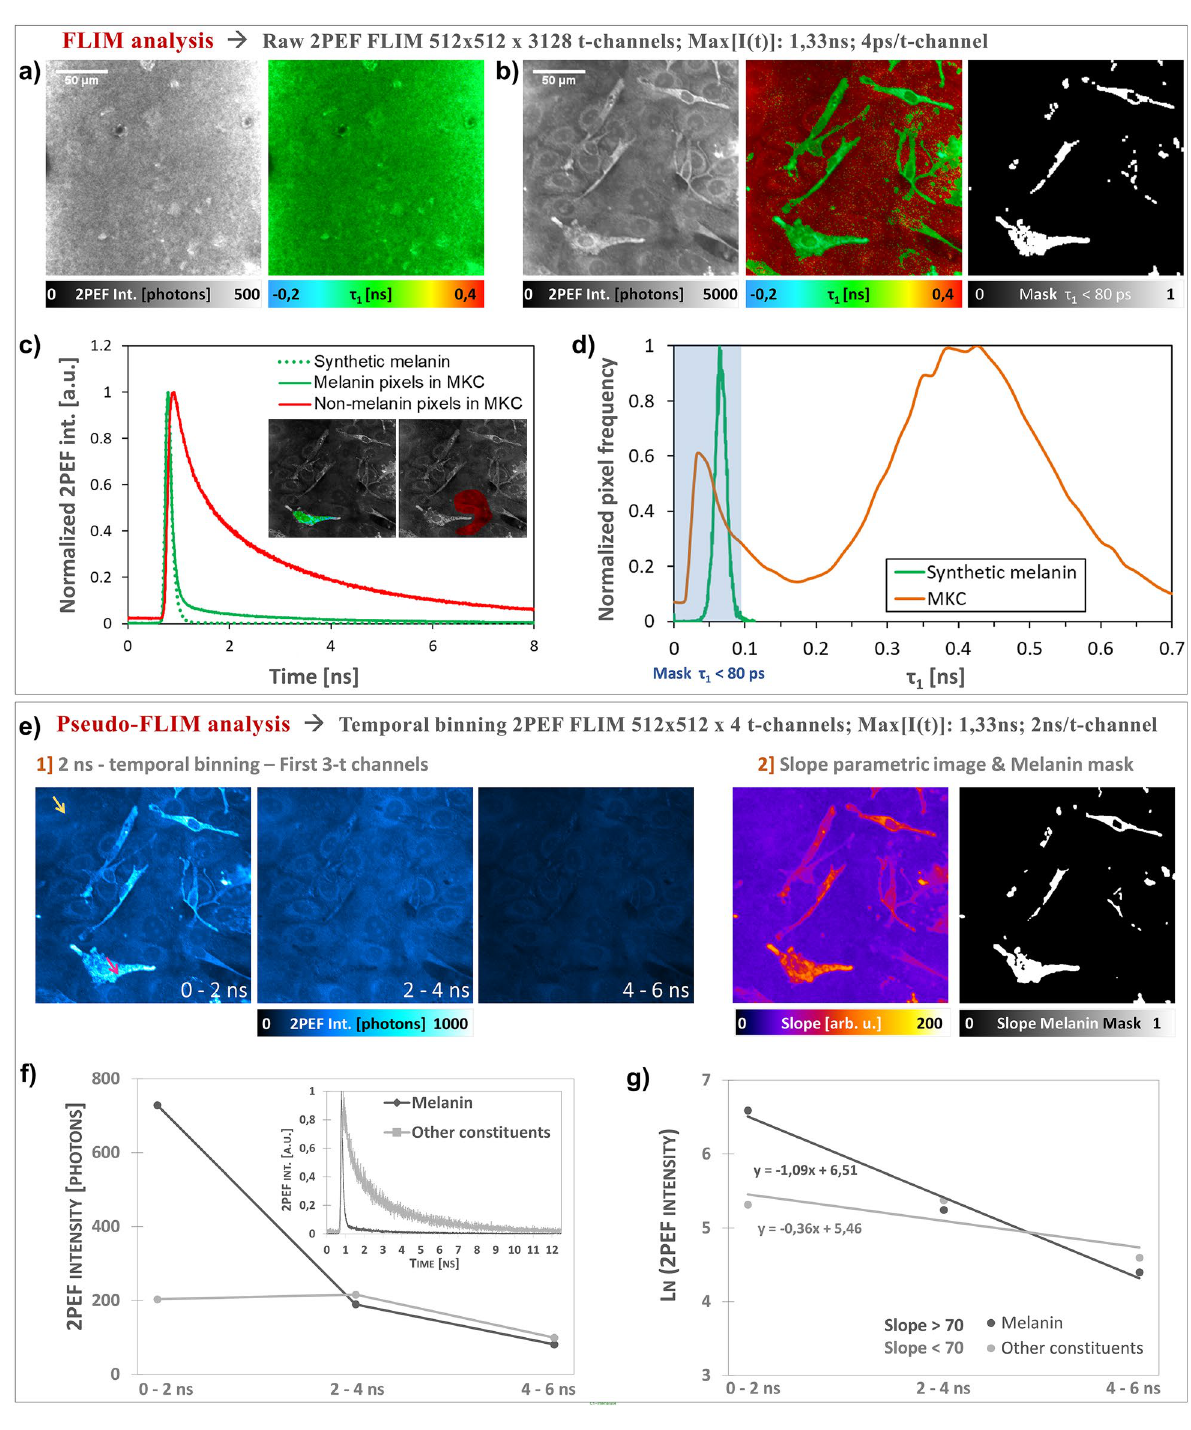
Figure 3. Comparison of FLIM bi-exponential fitting and Pseudo-FLIM methods for melanin detection. FLIM analysis – 2PEF intensity and τ 1 short-fluorescence lifetime images of ( a ) synthetic melanin and ( b ) normal human skin melanocytes and keratinocytes NHMK coculture. The FLIM τ 1 – based melanin mask is obtained by application of a threshold to keep the pixels with τ 1 values below 80 ps. ( c ) 2PEF intensity decays of synthetic melanin, melanin and non-melanin pixels within the NHMK coculture (averaged 2PEF intensity within the green and respectively red regions of interest). ( d ) Normalized histograms of the pixel frequency for τ 1 FLIM images of synthetic melanin ( a ) and NHMK coculture ( b ). The blue rectangle depicts the histogram regions selected by the application of a τ 1 < 80 ps threshold. ( e ) Pseudo-FLIM analysis of NHMK coculture, involving (1) a temporal binning of the 2PEF decay into a reduced number of time channels with 2 ns integration time per channel, followed by (2) an estimation of the slope of the decay after linear regression on the first 3 t-channels. ( f ) Example of resulting binned 2PEF decay of a melanin pixel (red arrow) and a non- melanin pixel (yellow arrow) selected based on their τ 1 value. ( g ) After a natural logarithm transformation, a linear regression of the first 3-time channels is performed to calculate the slope of the decay. The faster the decay, the higher the slope, as observed for these two melanin and non-melanin pixels. The image of the Pseudo-FLIM slope parameter in ( e ) is further processed for melanin detection to keep the high slopes values above 70 arb. u. and create a Pseudo-FLIM melanin